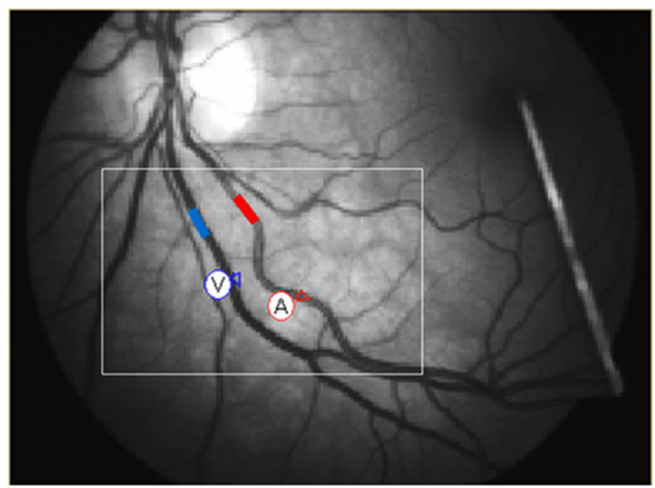
Figure 1. Example of retinal vessel selection before analysis.